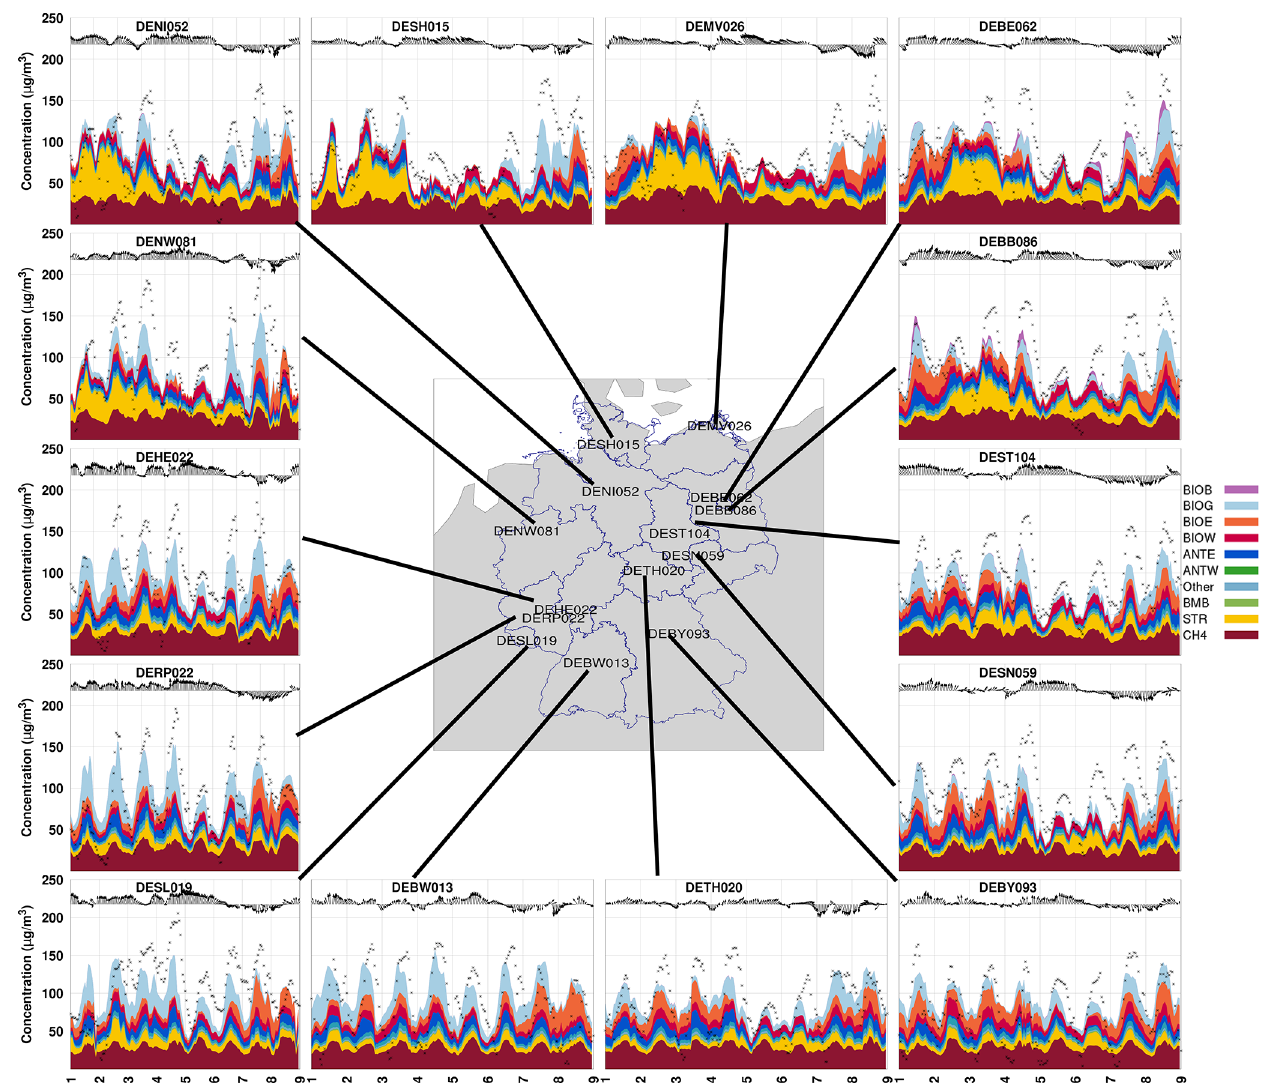
Figure 9. Contribution of regional VOC sources to hourly O 3 concentrations of local and other European sources, HTAP2 source regions, and other global source types at each station during the 1–8 August 2018 period. In addition, the vectors along the top of each panel represent the calculated wind speed and direction at 10ma.g.l. The black dots represent the observed O 3